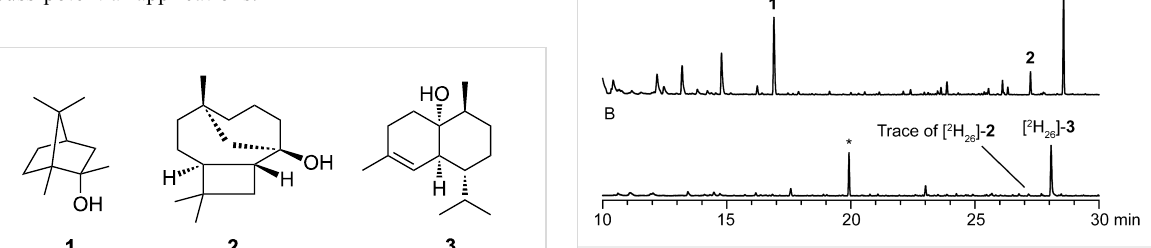
Figure 2: Total ion chromatograms of CLSA headspace extracts from S. griseus obtained after (A) incubation on 65.GYM agar and (B) incubation on DMM agar. The peak labelled “[ 2 H 26 ]- 3 ” is composed of [ 2 H 26 ]- 3 (17%), [ 2 H 25 ]- 3 (50%), and [ 2 H 24 ]- 3 (33%), as discussed in detail below. The peak labelled with an asterisk represents a contamin- ation with exo -bornyl acetate (non-deuterated) of unknown origin. Deuterated 1 could not be